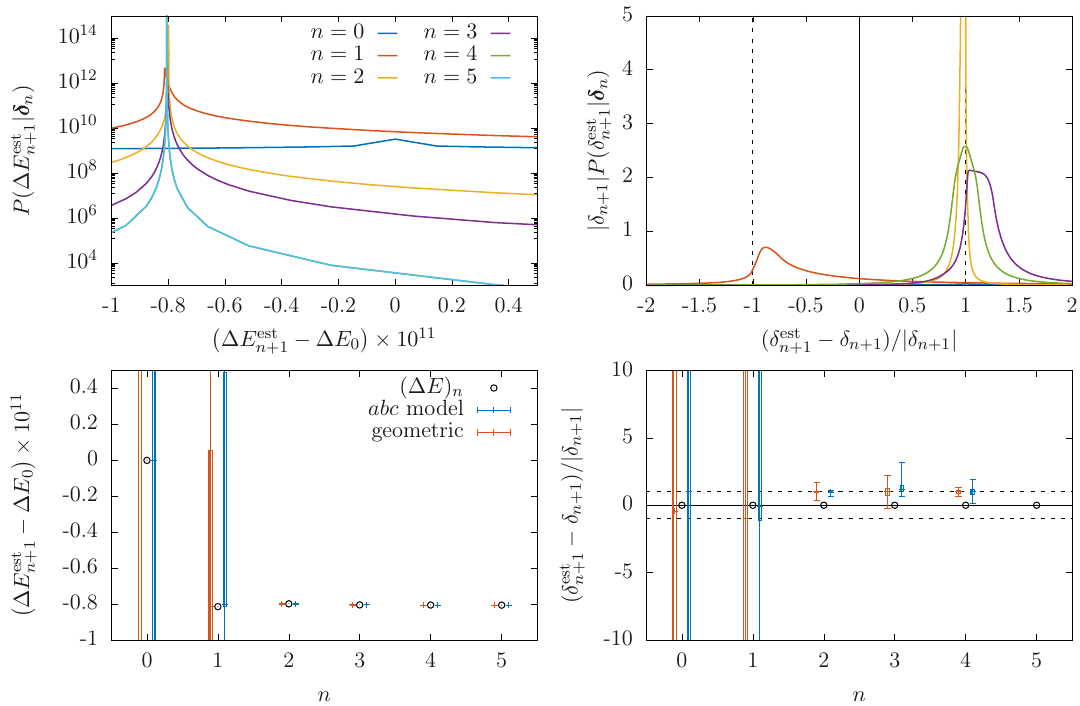
Figure 11 . The probability distribution and the CIs for the hyperfine-splitting ∆ E in units of the electron mass m . See the caption of figure e